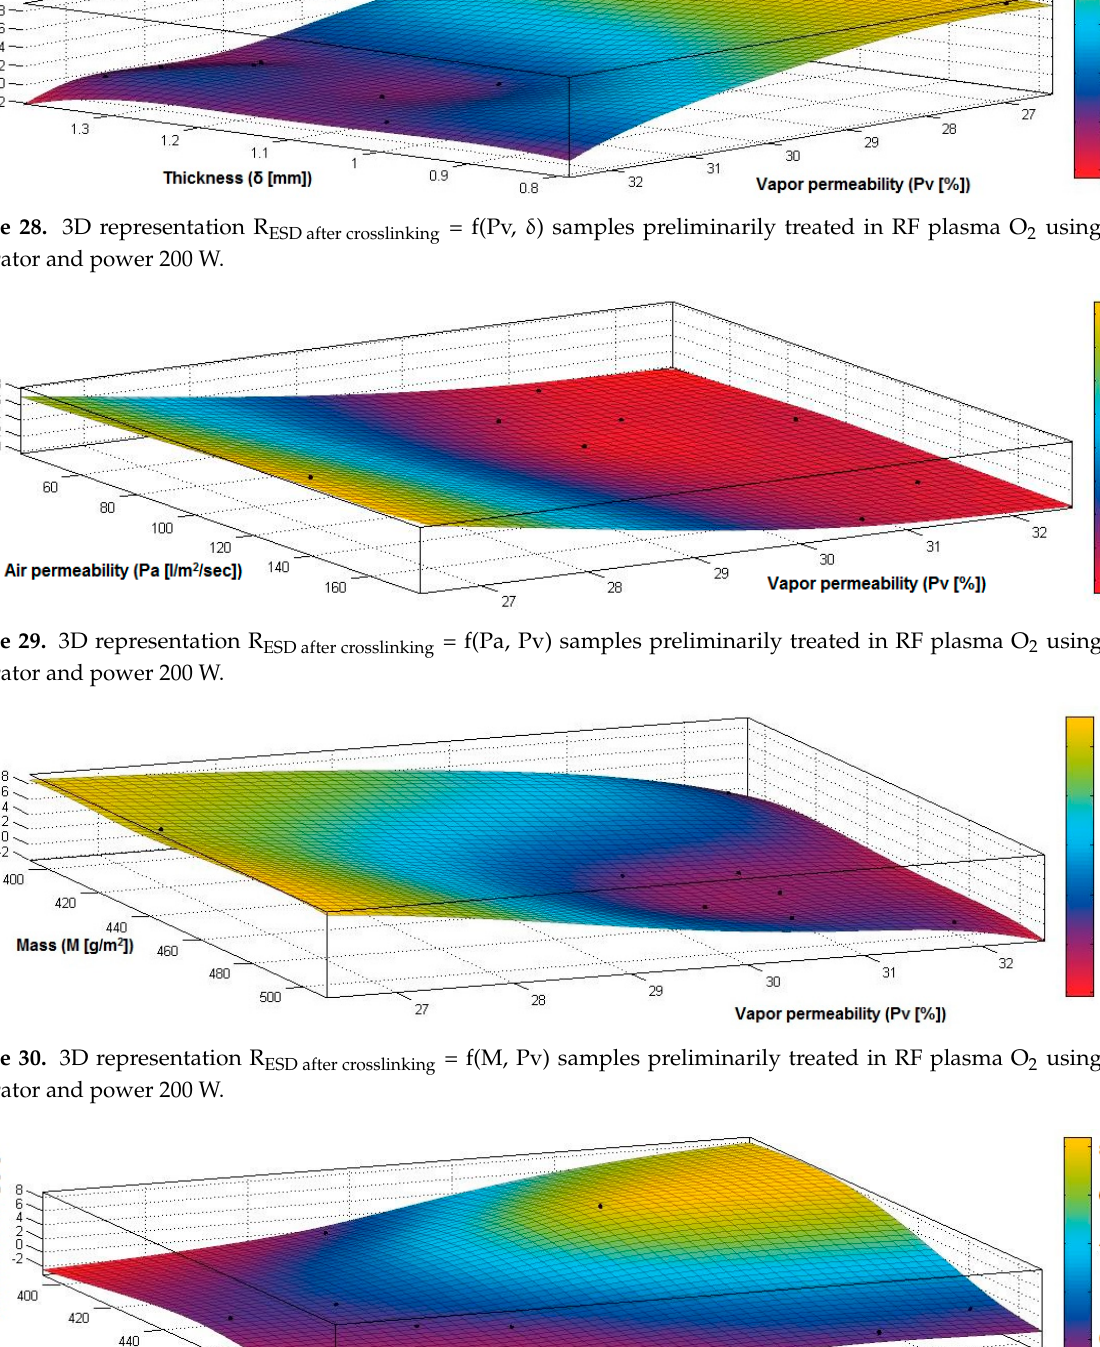
Figure 28. 3D representation R ESD after crosslinking = f(Pv, δ ) samples preliminarily treated in RF plasma O 2 using RF 1 generator and power 200 W.